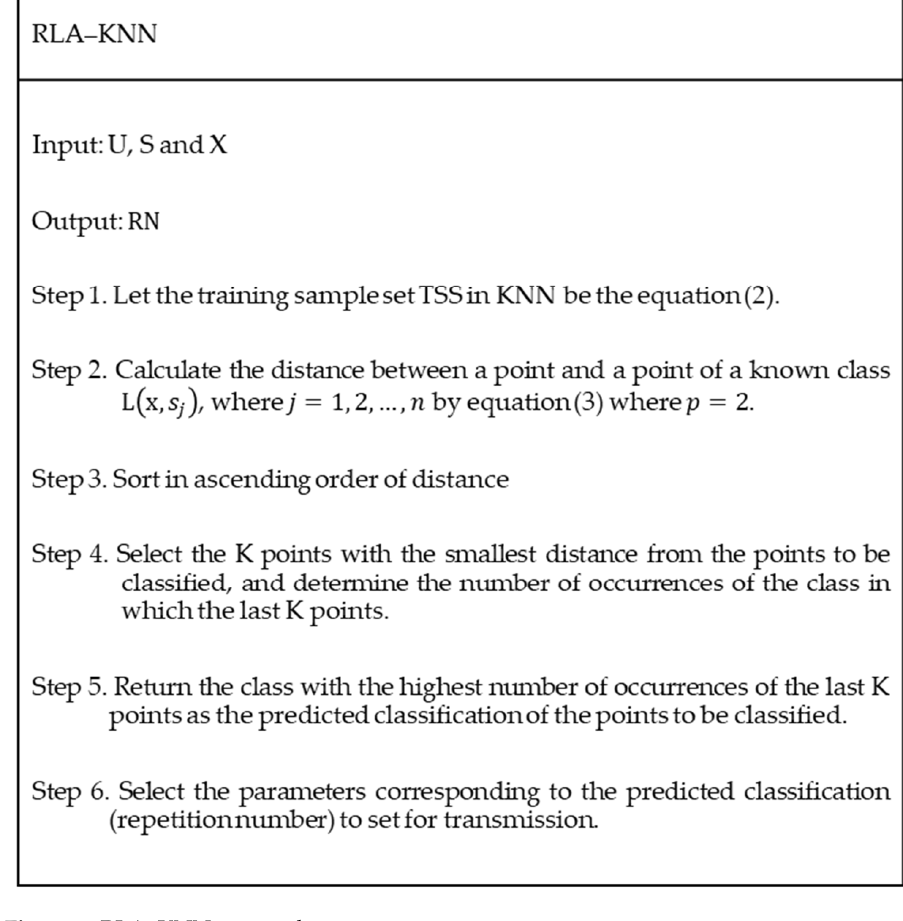
Figure 2. RLA–KNN